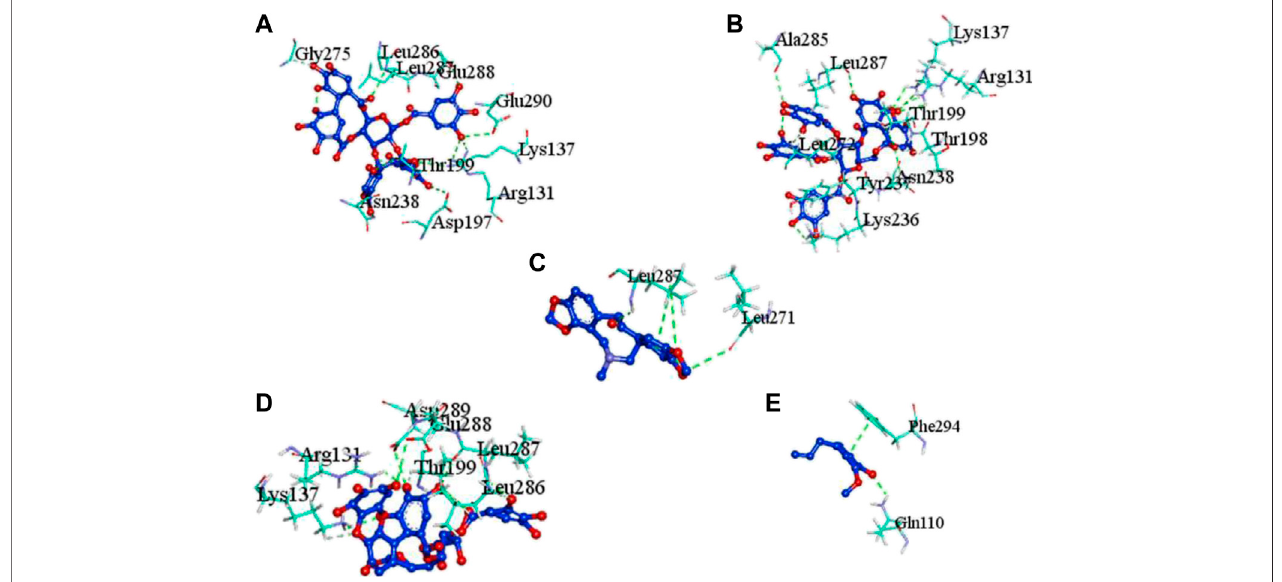
FIGURE3| Ligandoccupancyinanactivesiteofatargetproteincomplexmoleculeof (A) syringin, (B) eugeniin, (C) syzyginin, (B,D) eugenolacetate, (E) protopine, and (F) 1-methyloctyl acetate.